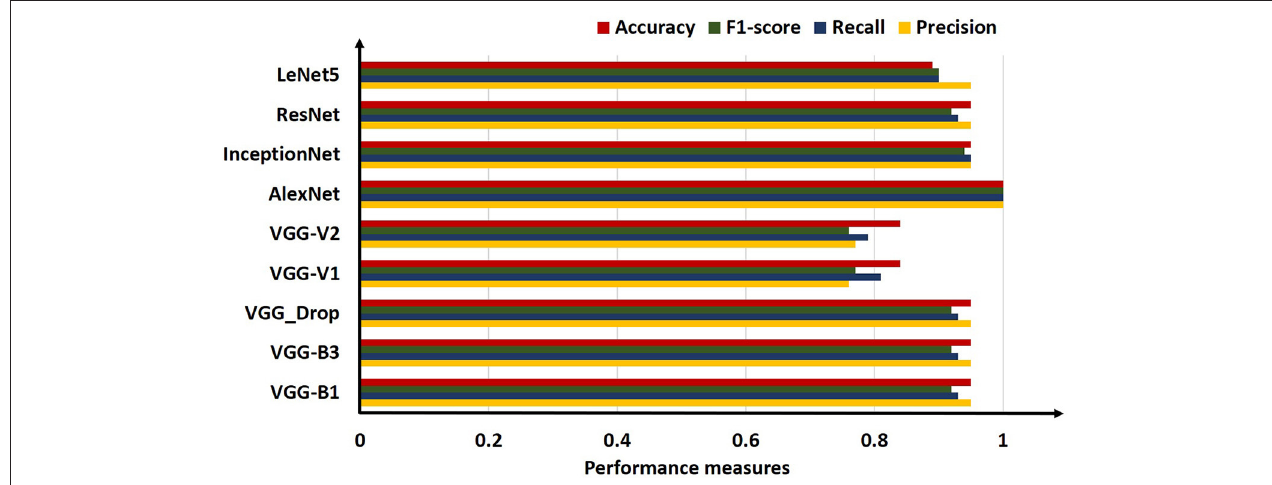
FIGURE 8 | Comparative bar chart visualization obtained for all algorithms employed.